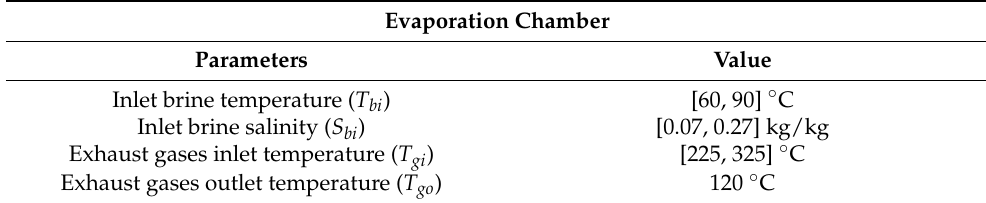
Table 3. Evaporation chamber